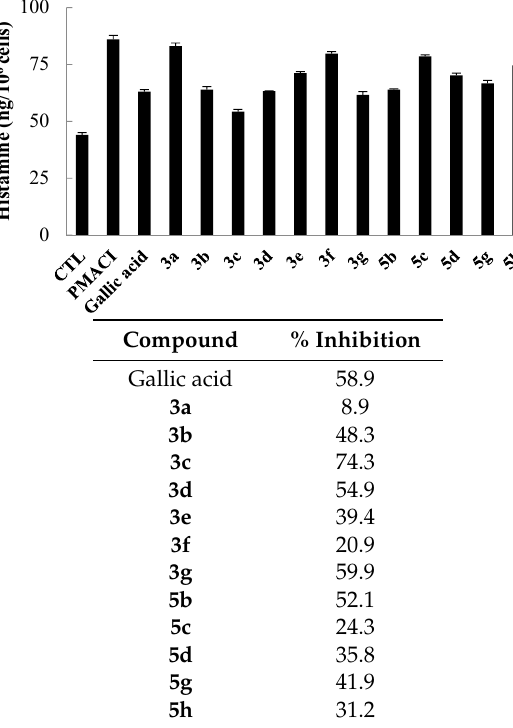
Table 1. Inhibitory activity of 3,4,5-trisbenzyloxy- and 3,4,5-trihydroxybenzamide analogs (10 µ M) on histamine release in HMC-1 cells.